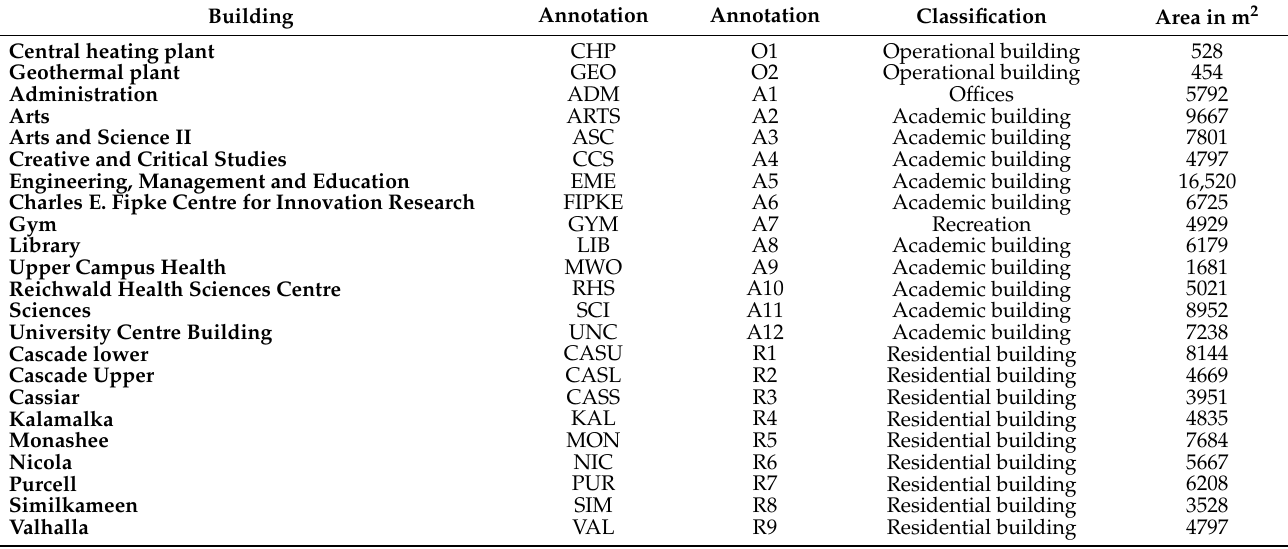
Figure A2. Heating degree days and cooling degree days. Table A1. Buildings investigated in this research.